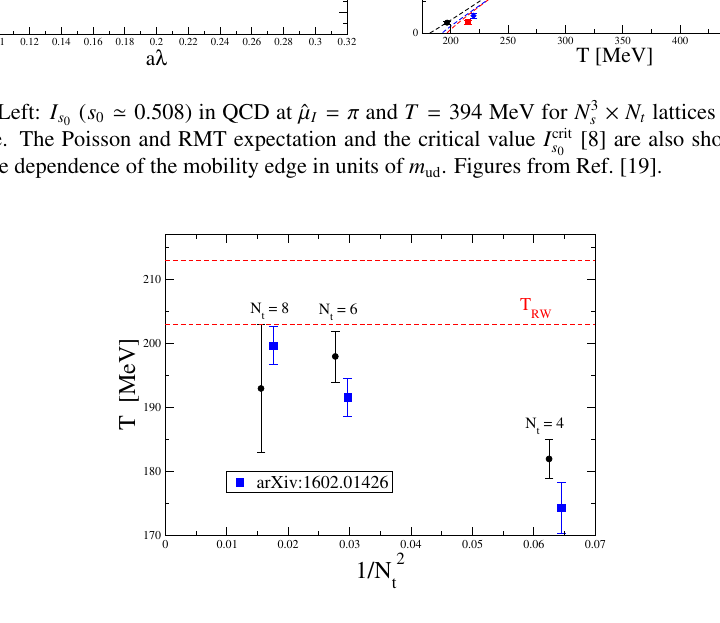
Figure 4. Localisation temperature T loc ( N t ) (black dots) and Roberge-Weiss temperature T RW ( N t ) (blue squares; data from Ref. [33]) for the various temporal extensions N t . The error band of the continuum extrapolation of T RW is also shown (red dashed lines). Figure from Ref.